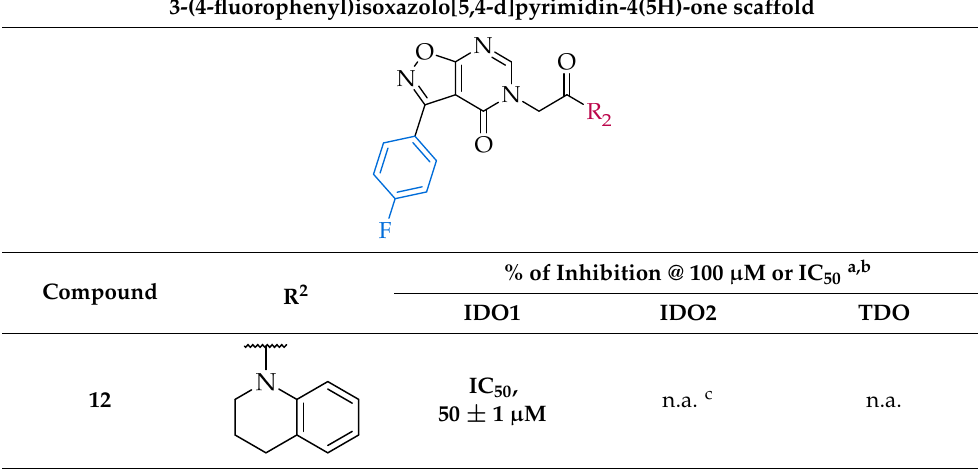
Table 1. Inhibitory potencies of synthesized compounds 12 – 37 with 3-(4-fluorophenyl)isoxazolo[5,4- d ]pyrimidin-4(5 H )- one scaffold against IDO1, IDO2, and TDO.